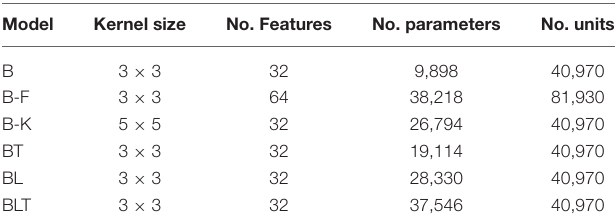
TABLE 1 | Brief descriptions of the models used in these experiments including the number of learnable parameters and the number of units in each model. Model Kernel size No. Features